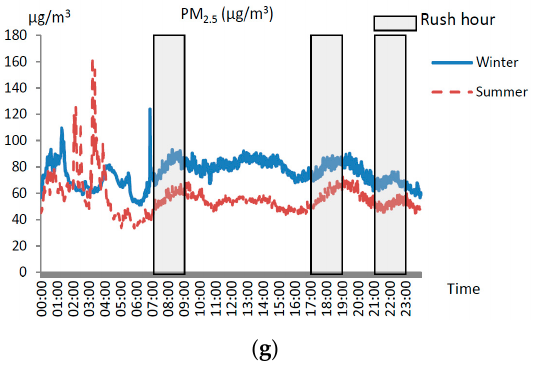
Figure 1. Mean hourly air quality measured from platforms of ten top most popular stations with top ridership in the Taipei Rapid Transit system (TRTS) in Taiwan. ( a ) CO 2 ; ( b ) CO; ( c ) O 3 ; ( d ) humidity; ( e ) temperature; ( f ) PM 10 ; and ( g ) PM 2.5 .